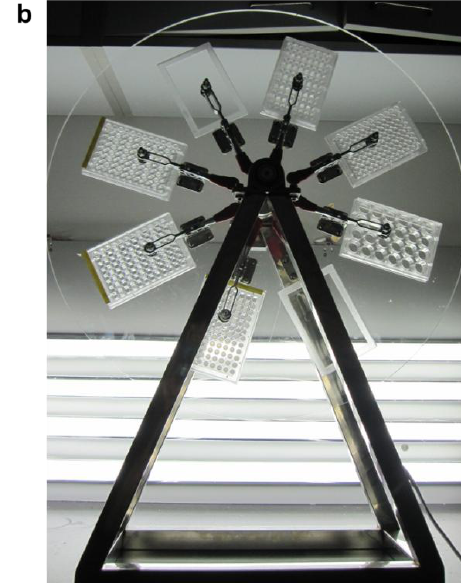
Figure 1. ( a ) Schematic diagram of the 96-well microplate swivel system. Different concentrations of CO were sealed into each microplate by 2 membrane layers. External 2 continuous illumination at 180 μmol m −2 s −1 was provided by cool white fluorescent lights. During cultivation, microplates on the swivel were rotated vertically. Cell density was measured daily with a microplate reader; ( b ) Photo of 96-well microplate